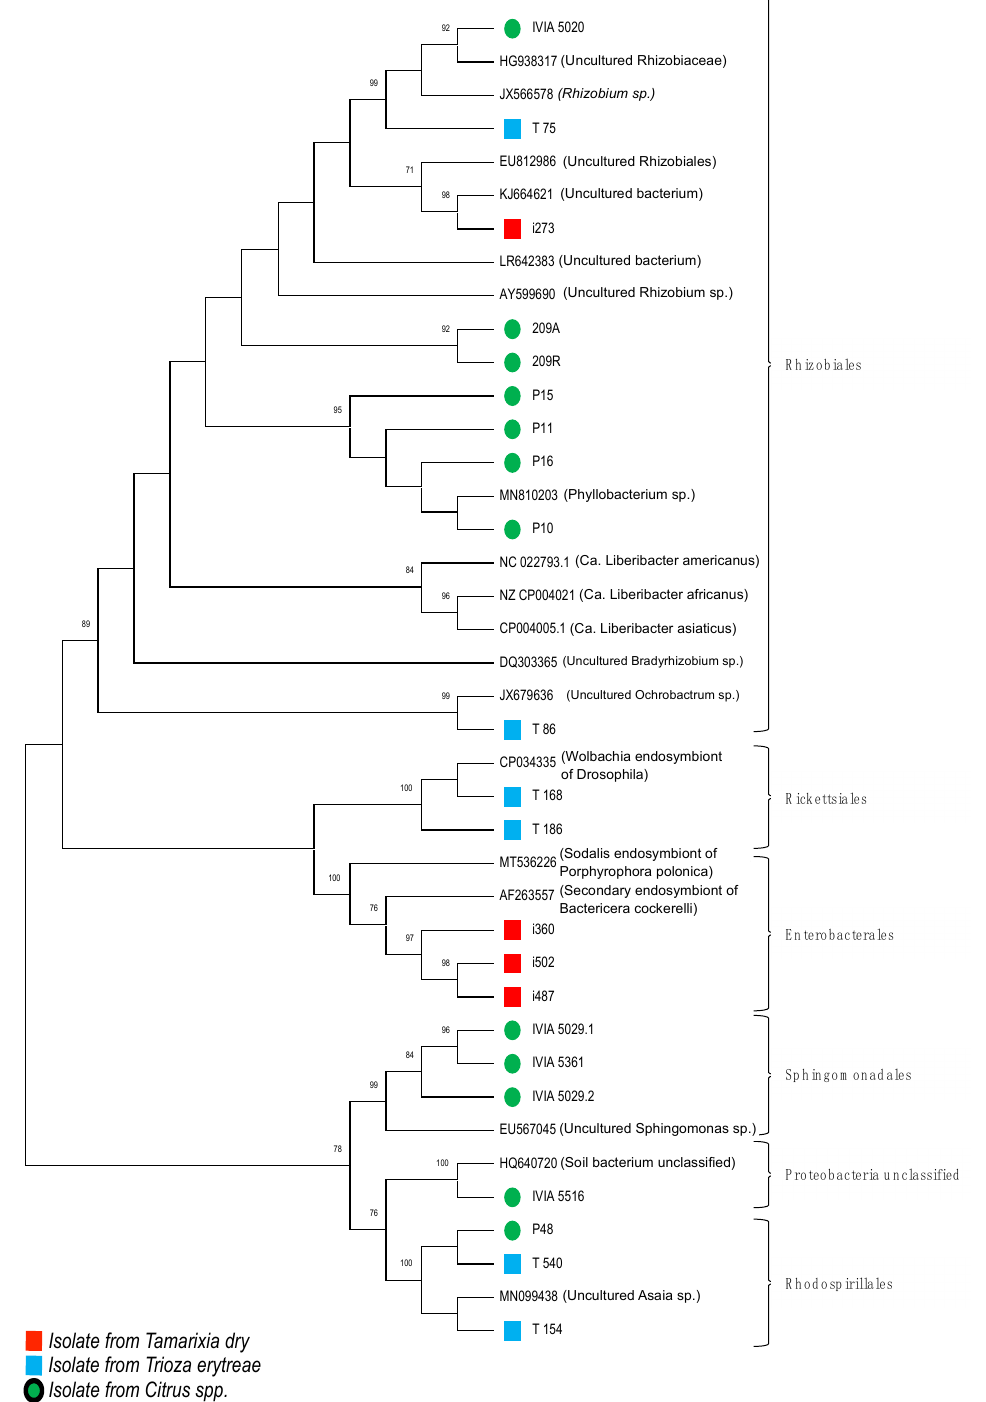
Isolate from Tamarixia dry Isolate from Trioza erytreae Isolate from Citrus spp. Figure 2. Phylogenetic analysis by the Maximum likelihood method of a fragment of 16S ribosomal DNA gene from those samples that were amplified with Bertolini et al. [19] and Li et al. [21] protocols. Trees were generated under the Tamura 3 model [40] of nucleotide substitution. Branches are supported by 1000 bootstrap replicates.